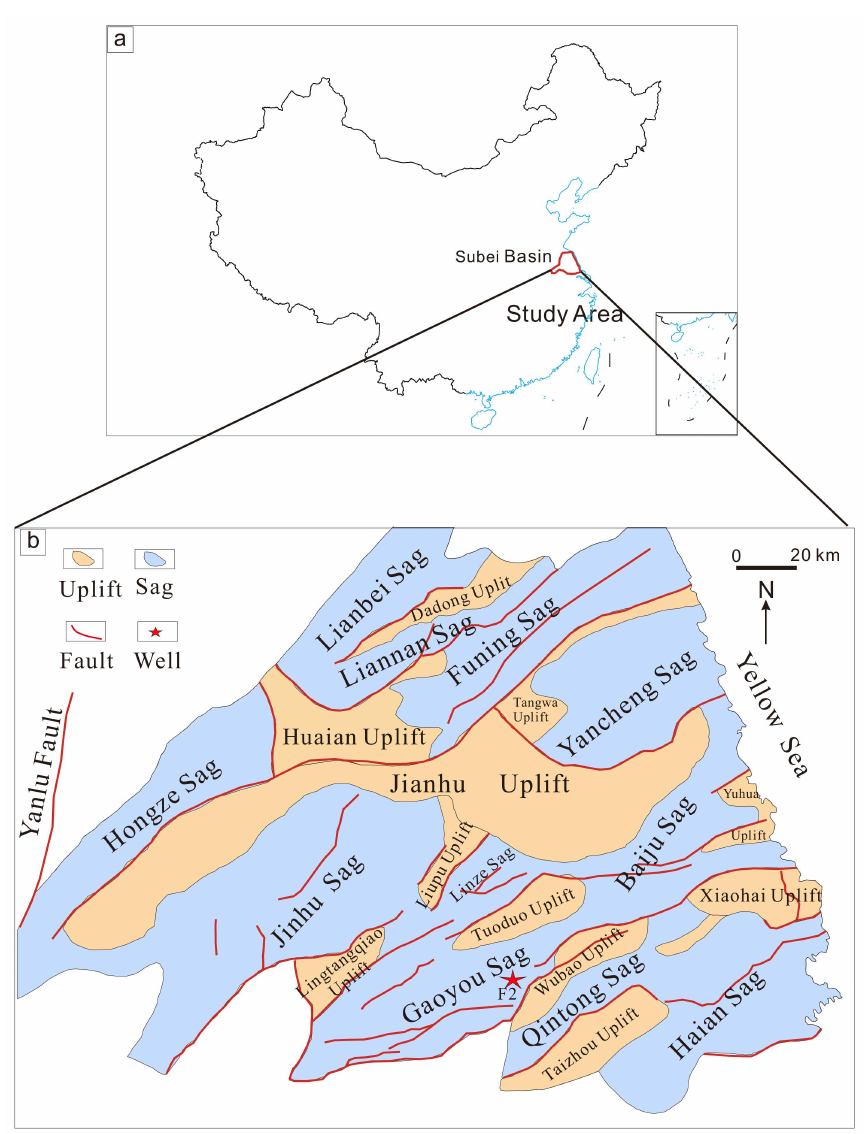
Figure 1. ( a ) Location of the Subei Basin and ( b ) map of the study area in the Gaoyou